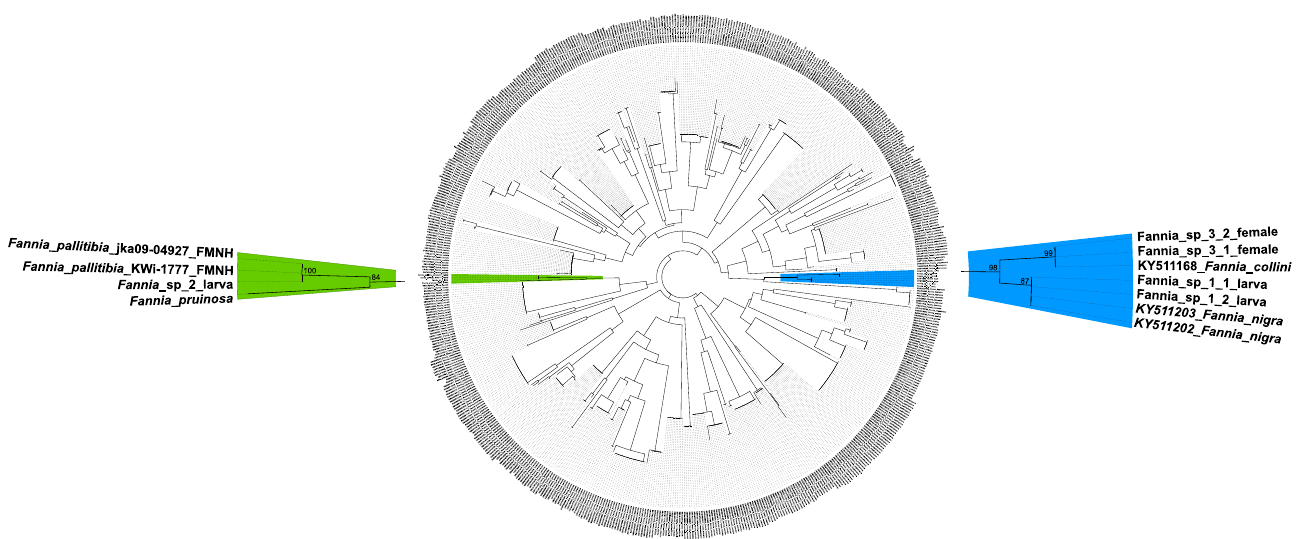
Figure 1. Neighbor joining phylogenetic analysis of 596 COI barcode sequences representing 67 species of Fannia retrieved from BOLD and GenBank supplemented with six newly obtained sequences, including three query morpho-species and Fannia pruinosa . Values above nodes indicate support for sequence clusters obtained from 1000 bootstrap replications.